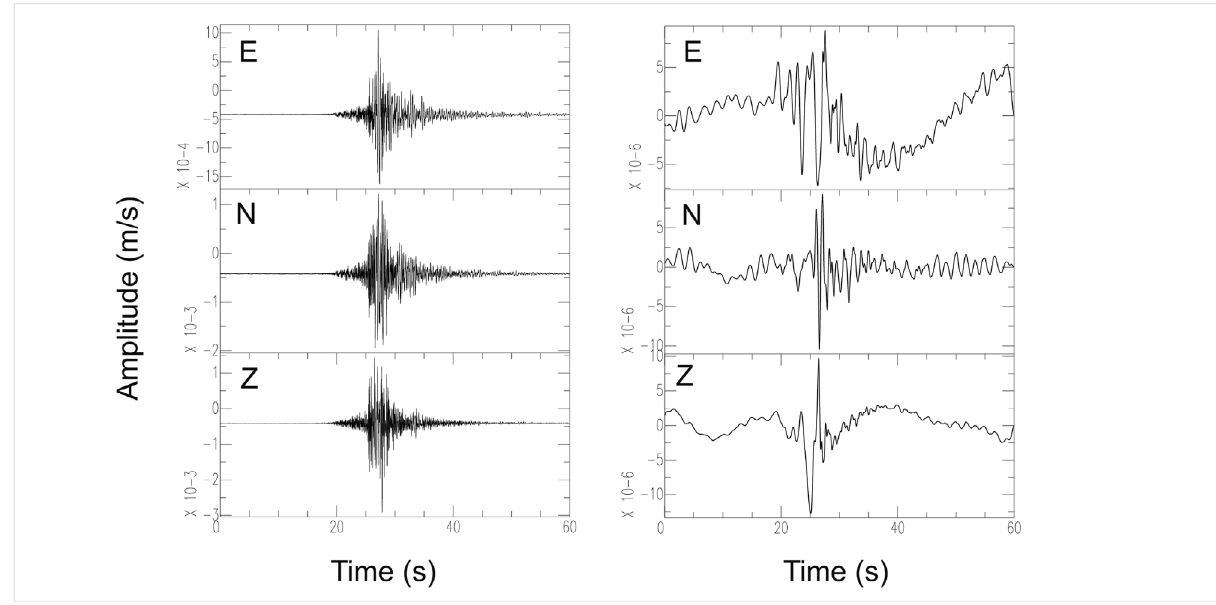
Figure 8. Waveforms of the major landslide recorded by the VCRE station on June 5, 2009, at 04:04 UTC. In the right panels the 1 Hz low pass filtered signals are